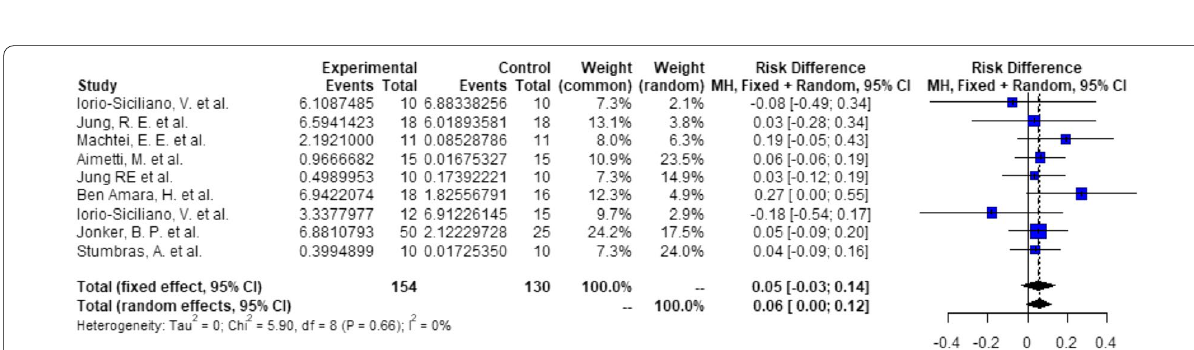
Fig. 9 Meta-analysis results for the binary outcomes for implant placement in a bone envelope of 9.0